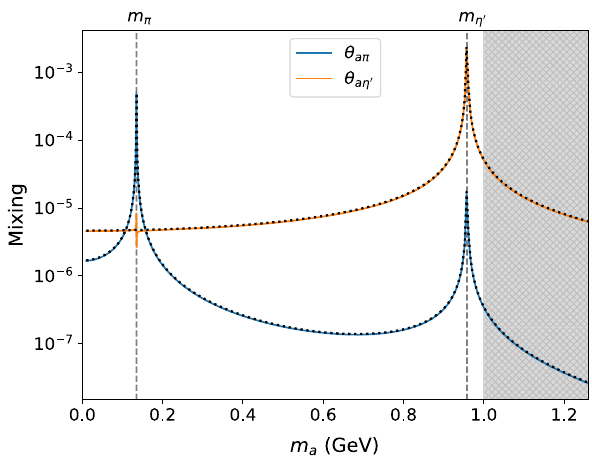
Fig. 1 Mixing angles as a function of the (heavy) axion mass m a , for a value of f a = 10TeV. The grey area indicates the range where the validity of the chiral expansion breaks down. The figure also applies to gluonic